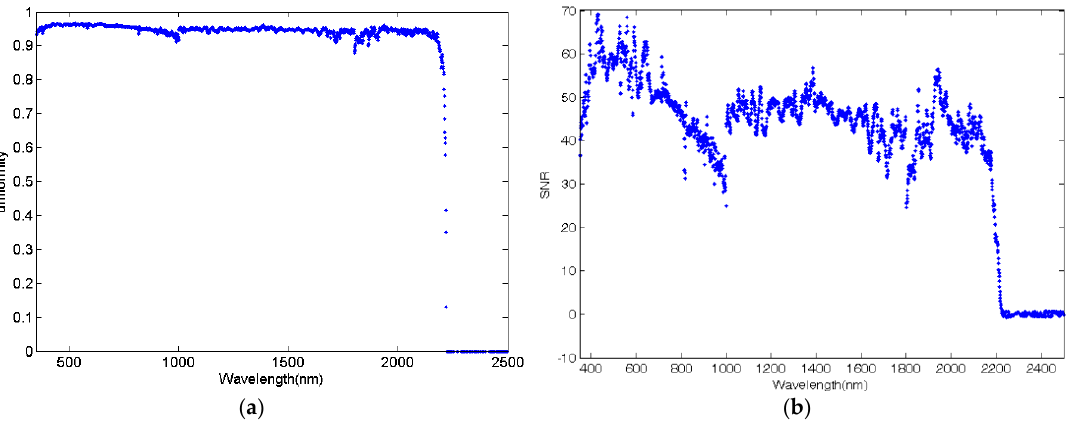
Figure 6. The spectral non-uniformity of the skylight simulator: ( a ) The spectral non-uniformity of the skylight simulator in 350–2500 nm spectral region and ( b ) the signal-to-noise ratio (SNR) of spectral irradiance collected with an ASD field spectrometer.